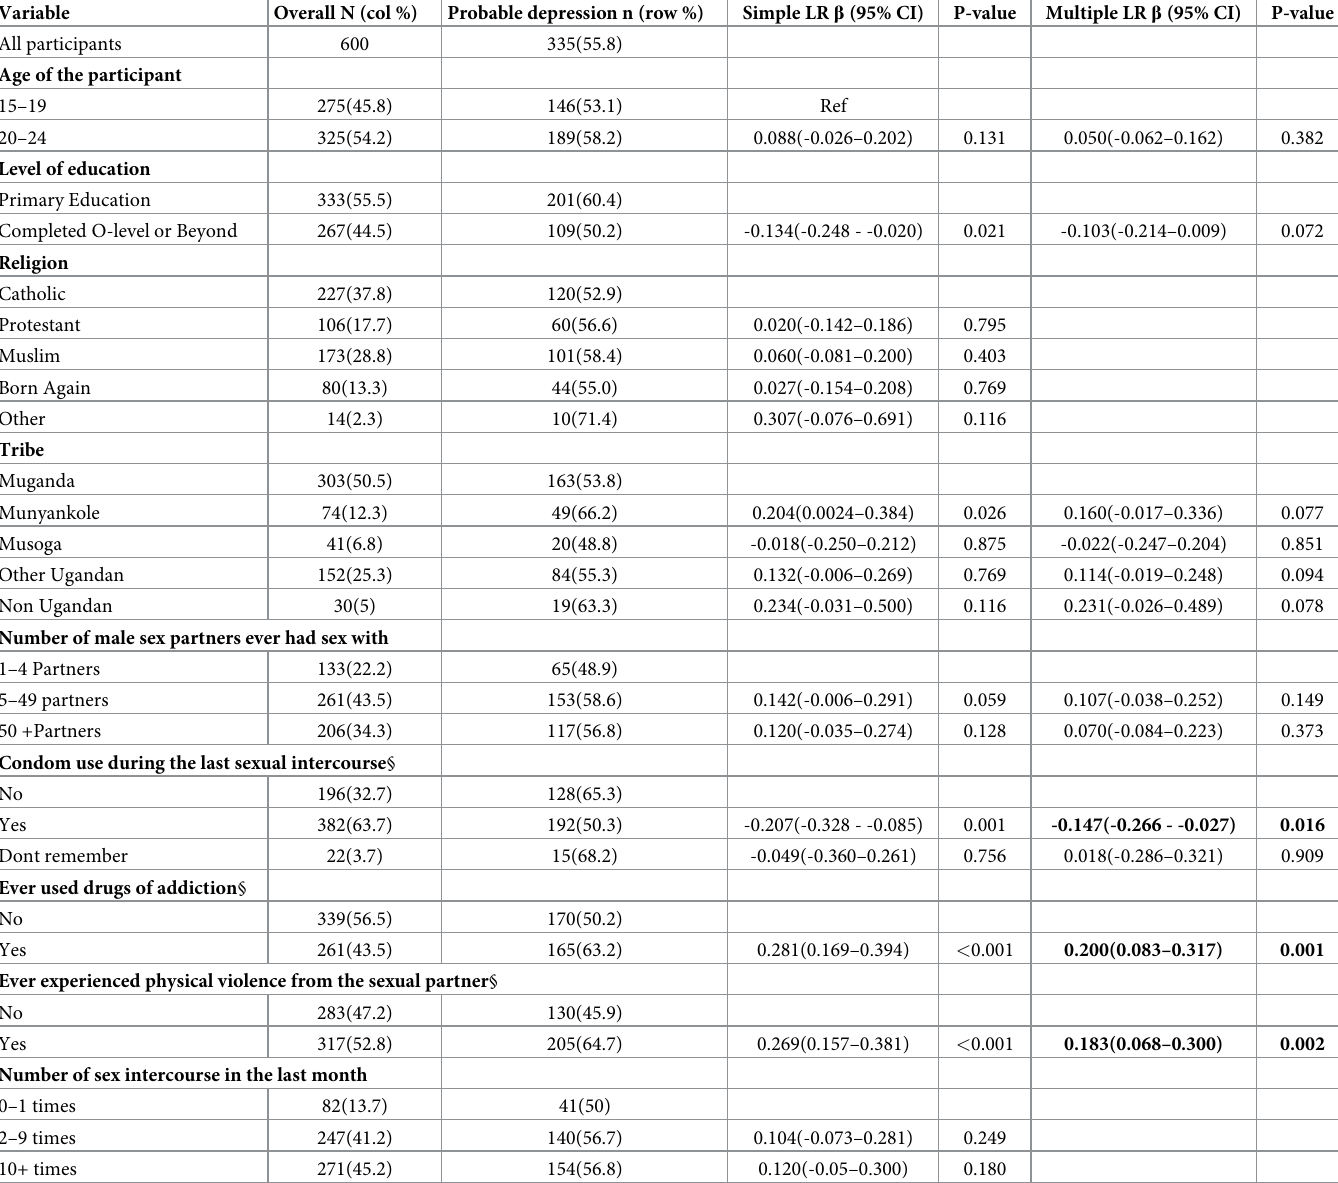
Table 1. Descriptive and multivariable regression model of the factors associated with mean HSCL depression symptoms score among young women at high risk aged 15–24 years in Kampala,